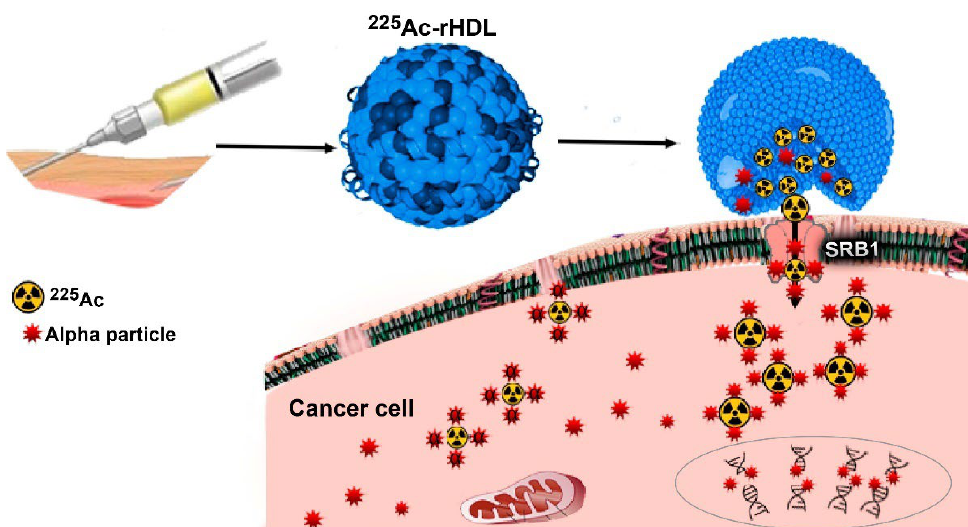
Figure 6. Cellular interaction mechanism of rHDL containing 225 Ac. Once endogenous rHDL interacts with the SR-BI receptor found on the surface of the cell membrane, its content is released directly into the cell’s cytoplasm. Therefore, 225 Ac-rHDL is an effective nanosystem for depositing within the malignant cells, an in vivo generator for alpha particle radiotherapy, which delivers lethal radiation doses to cells due to the four alpha particles emitted by 225 Ac and its progeny in each nuclear transformation. The ionizations produced by 225 Ac and its daughters produce direct damage to the DNA structure, preventing tumor proliferation.